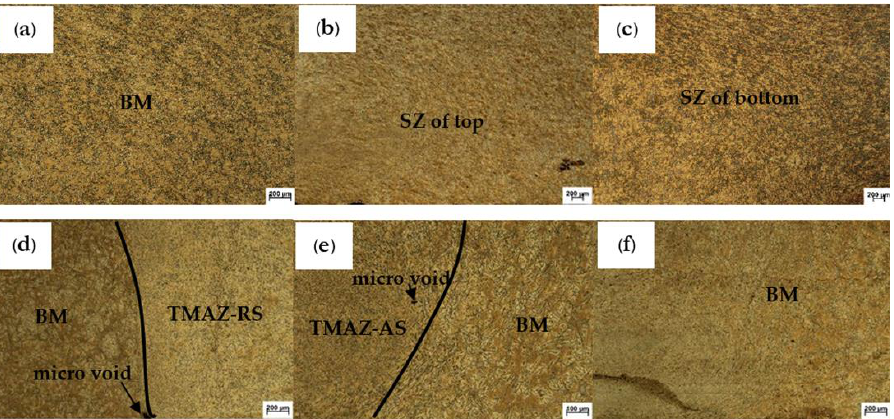
Figure 10. The microstructure photography evaluation by OM of optimal welding conditions of D-optimal: ( a , f ) BM, ( b , c ) SZ, ( e ) TMAZ-AS, and ( d ) TMAZ-RS.